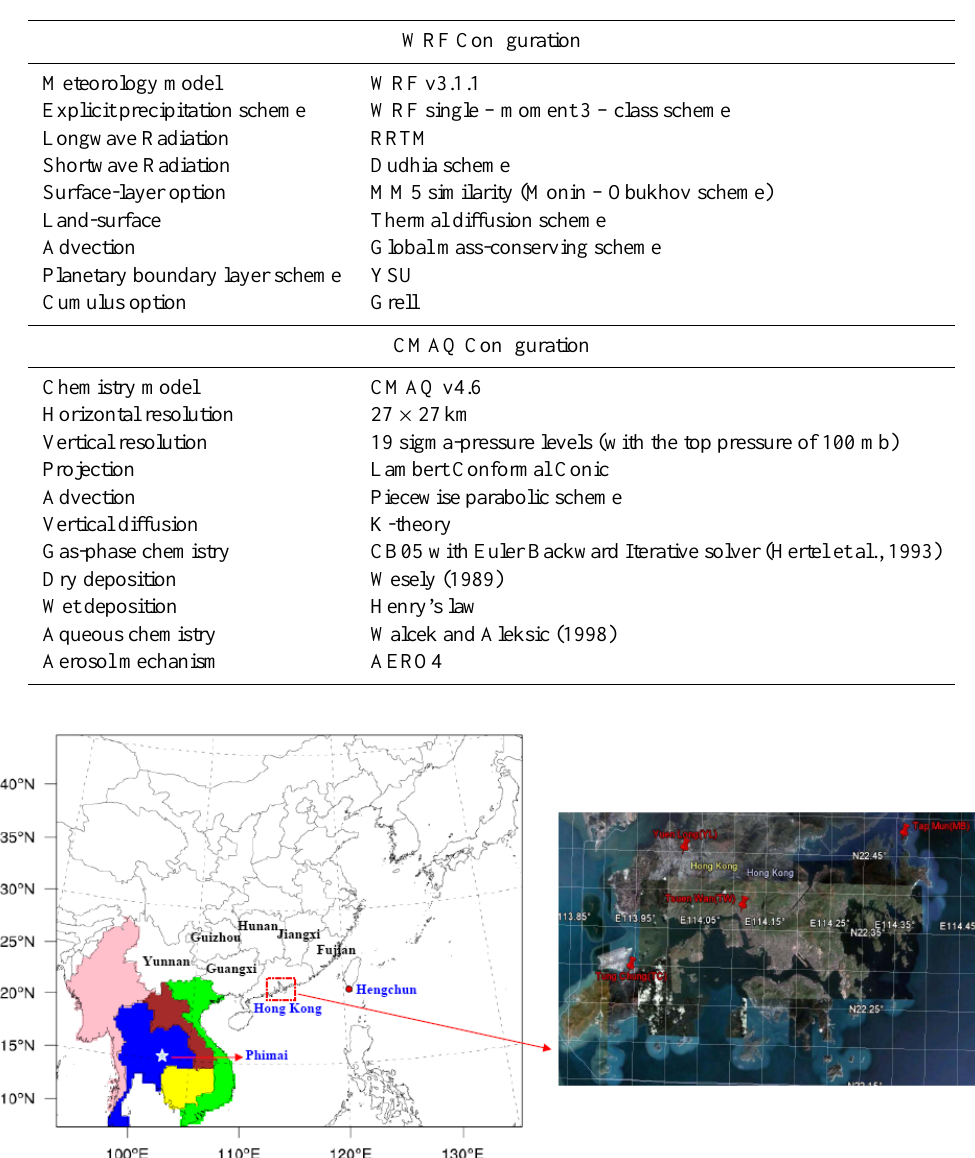
Table 1. Model configuration of WRF and CMAQ.